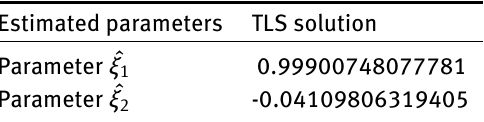
Table 16: TLS solution for the 2D similarity